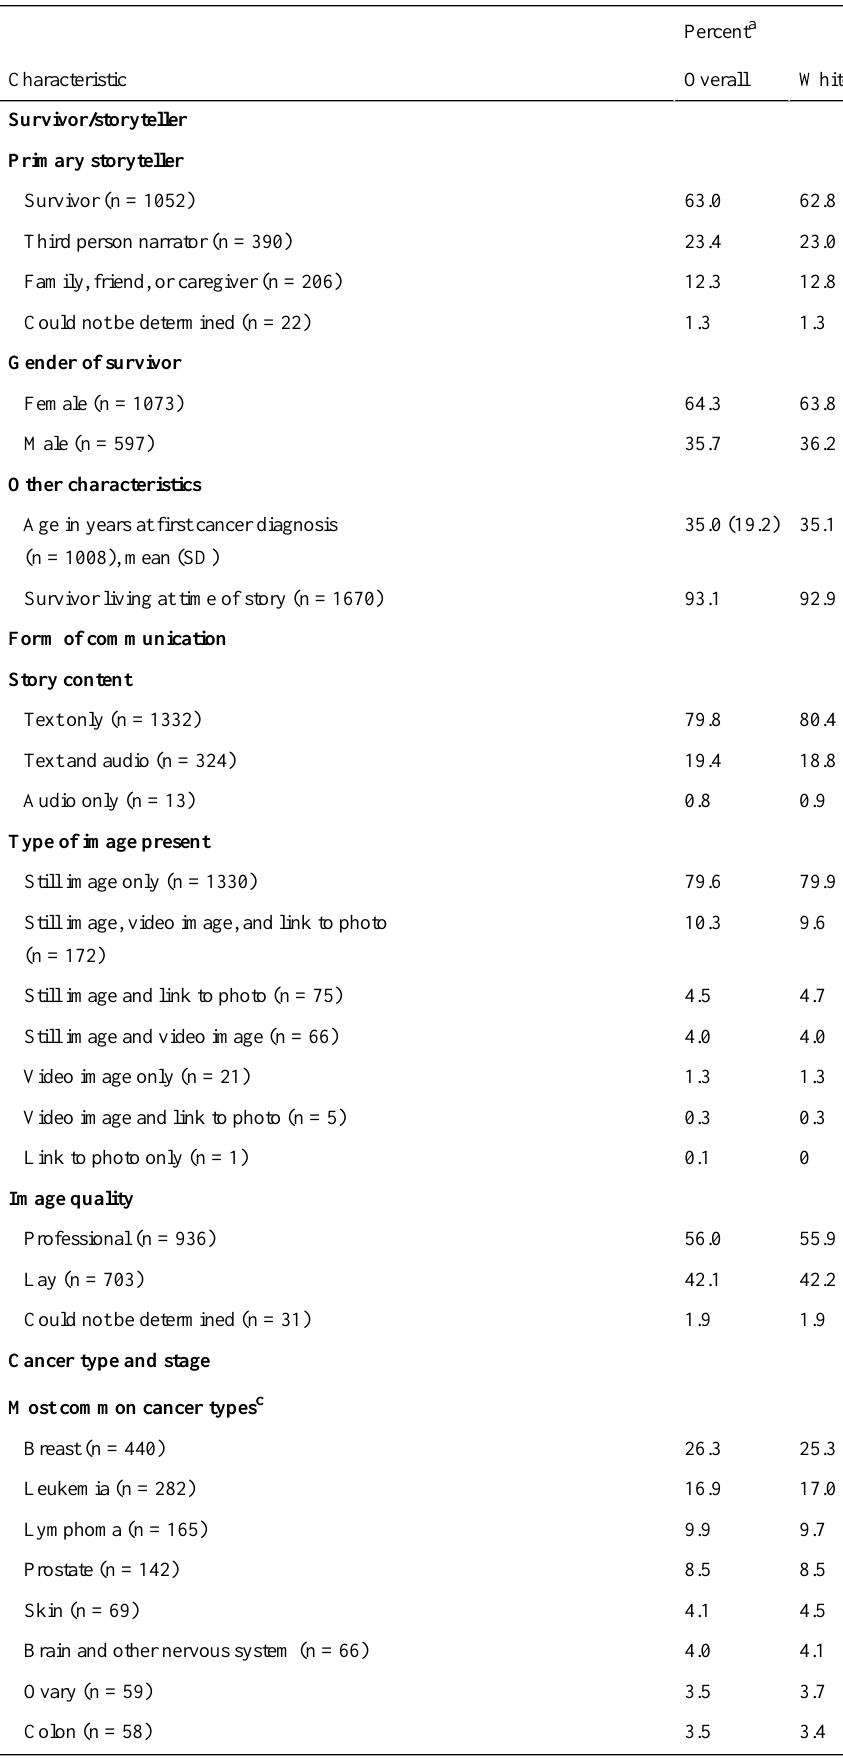
Table 2. Characteristics of cancer survivor stories (n =